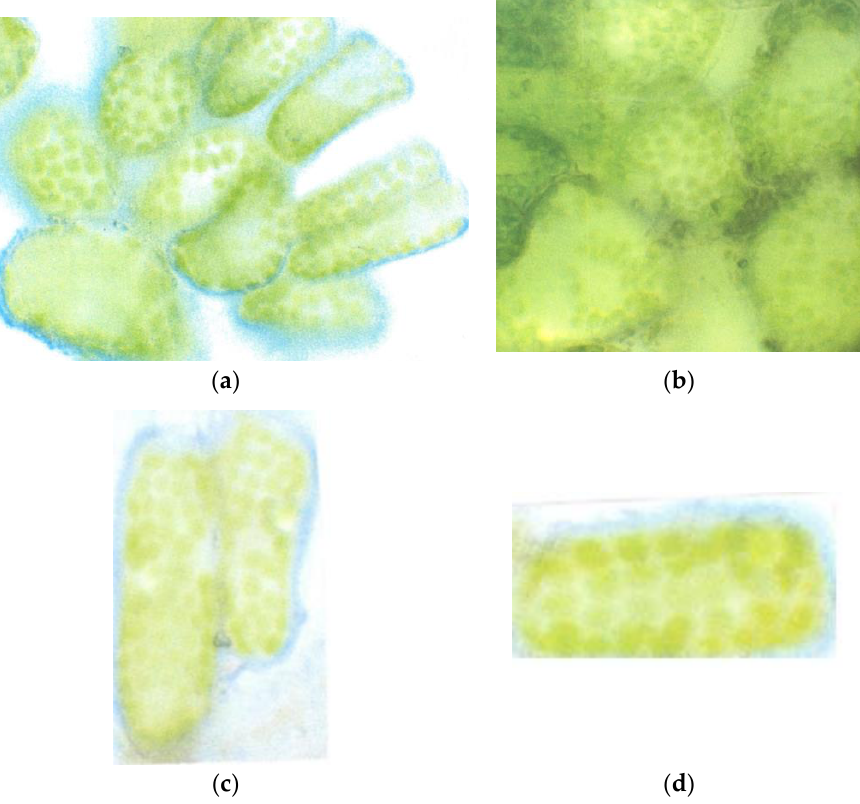
Figure 8. ( a - d ) Restoration of the chloroplasts during winter time.